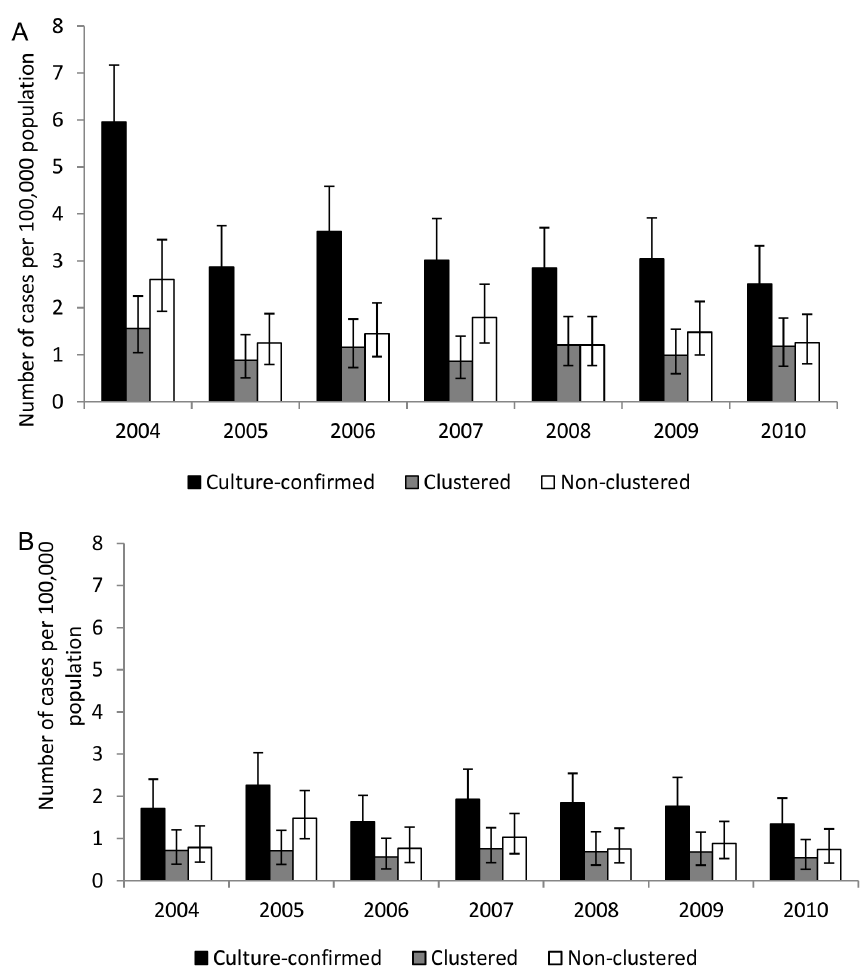
Figure 3. Comparison of culture-confirmed, clustered, and non-clustered tuberculosis cases by sex. Comparison of incidence trends of culture-confirmed, clustered, and non-clustered cases of tuberculosis reported in Arkansas from 2004 to 2010 between two sexes. a: among males; b: among females.